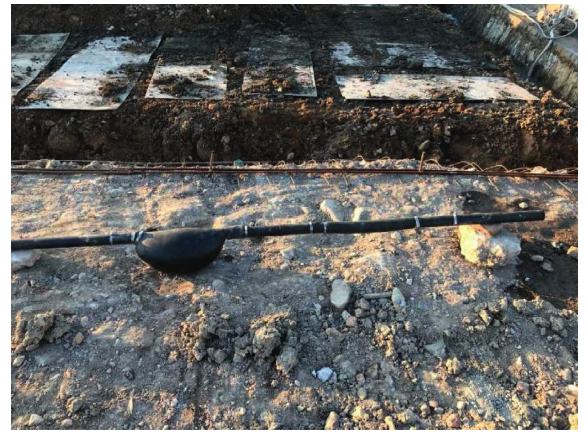
Figure 6: Differential expansion of airbags.